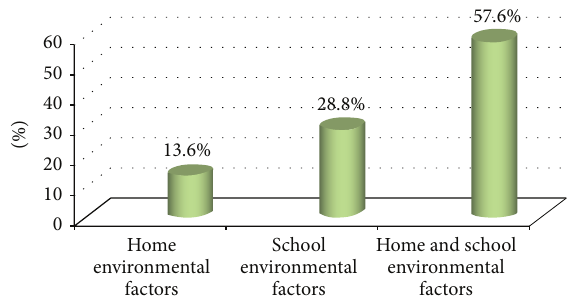
Figure 2: Contribution of learning environmental factors to poor academic performance. Source: field survey